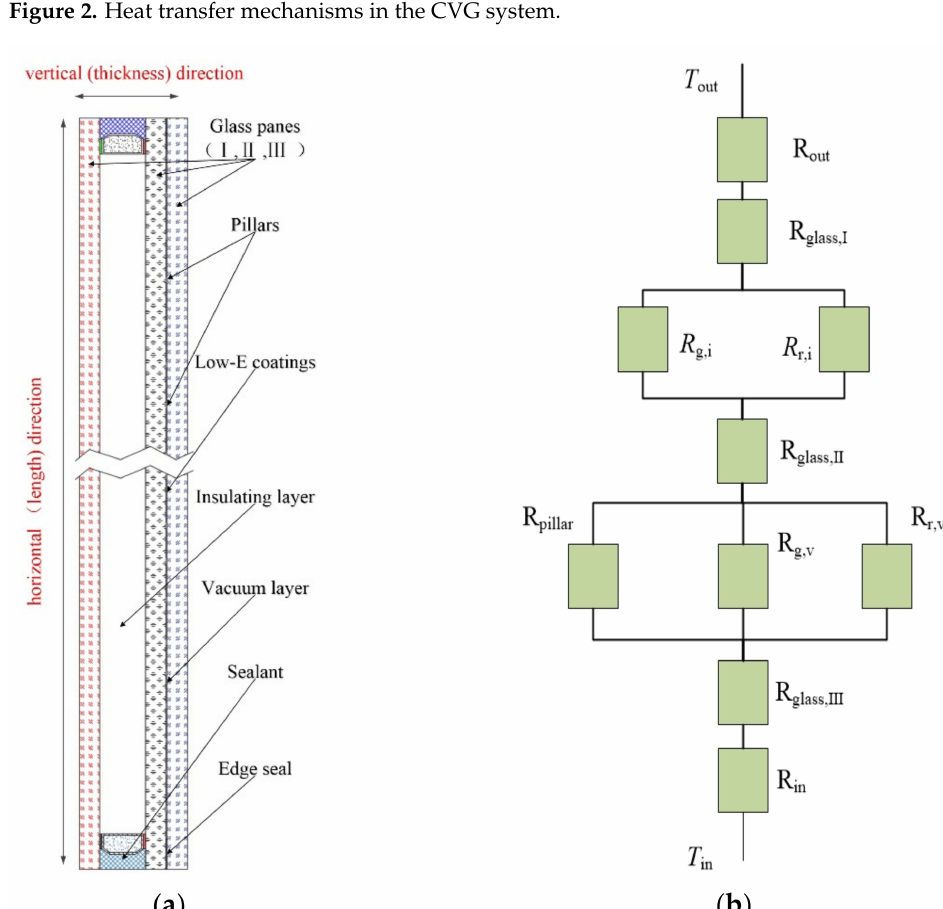
Figure 3. ( a ) Simplified CVG model; ( b ) Thermal resistance in the central